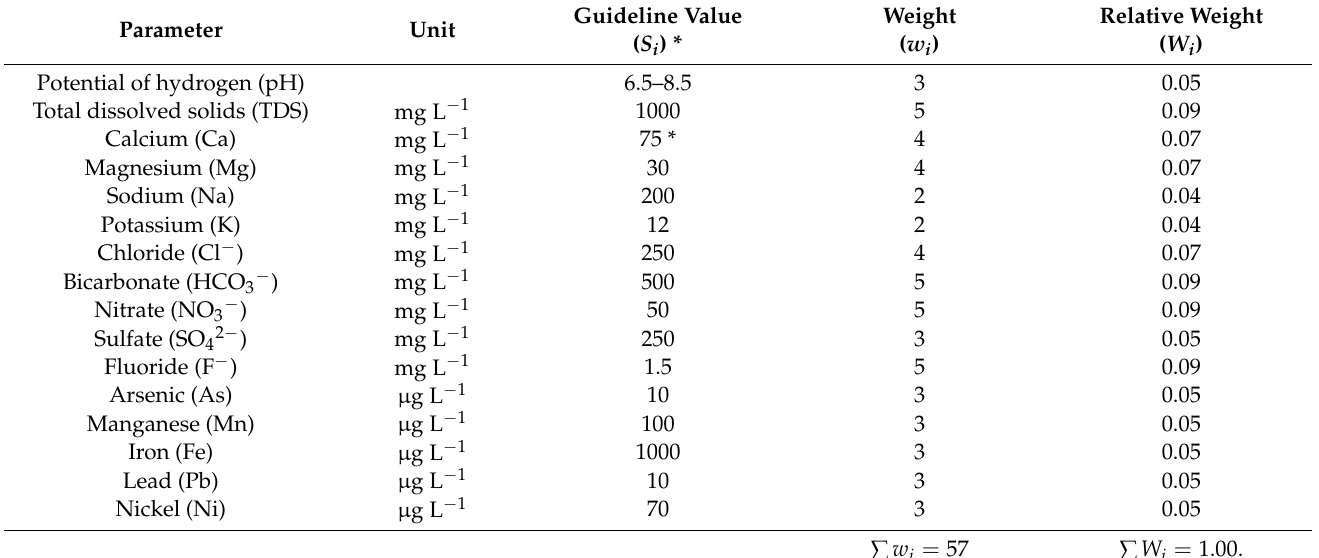
Table 2. List of the groundwater quality parameters guideline value ( S i ), weight ( w i ) relative weight ( W i ), used for the groundwater quality index